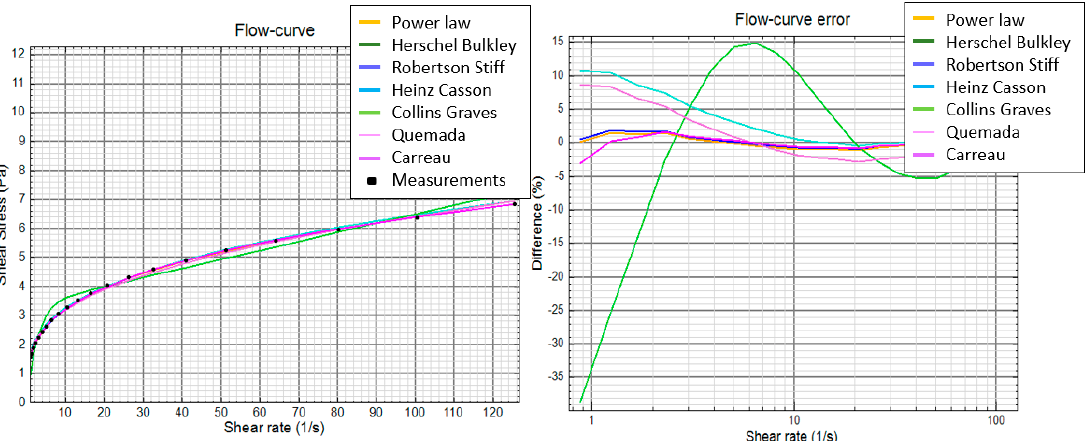
Figure 3. For a KCl/Polymer 1250 kg/m 3 at 80 °C, the best matching rheological behavior is the power Figure 3. For a KCl / Polymer 1250 kg / m 3 at 80 ◦ C, the best matching rheological behavior is the power law model. law